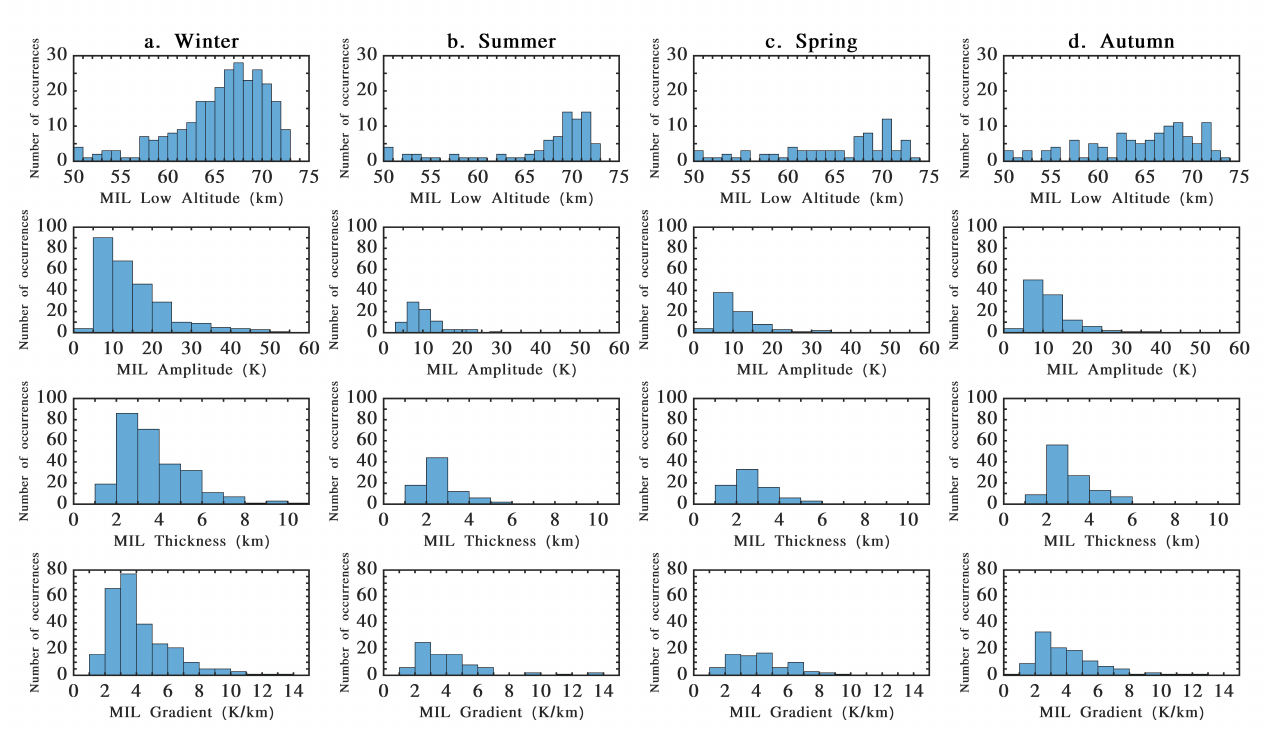
Figure 4. Histogram of the occurrence of MIL characteristics (amplitude, minimum altitude, thickness, and gradient) by